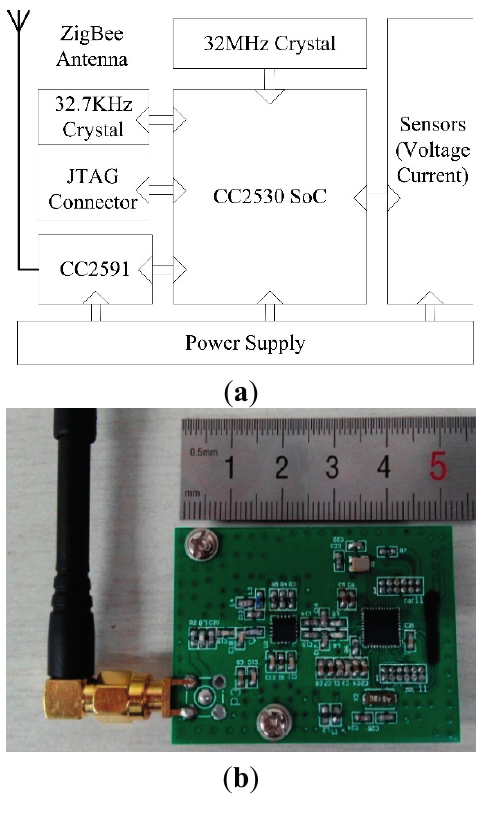
Figure 3. The sensor node’s block diagram ( a ) and physical implementation ( b